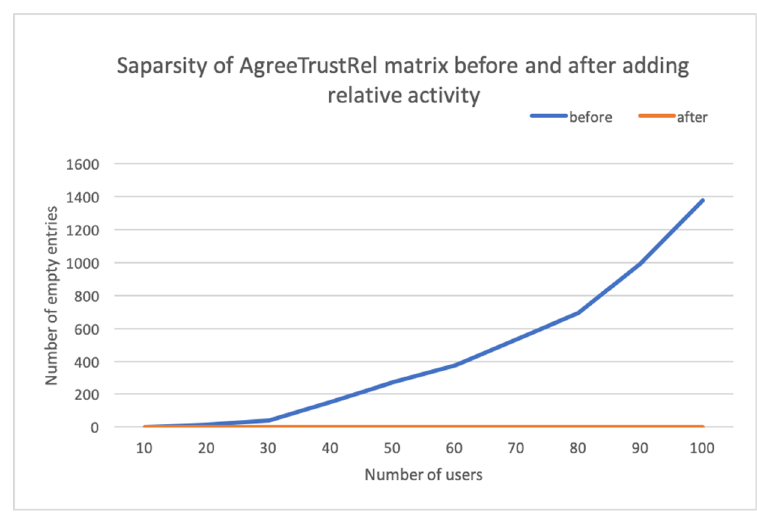
Figure 5. Sparsity of the AgreeRelTrust matrix before and after adding relative activity.